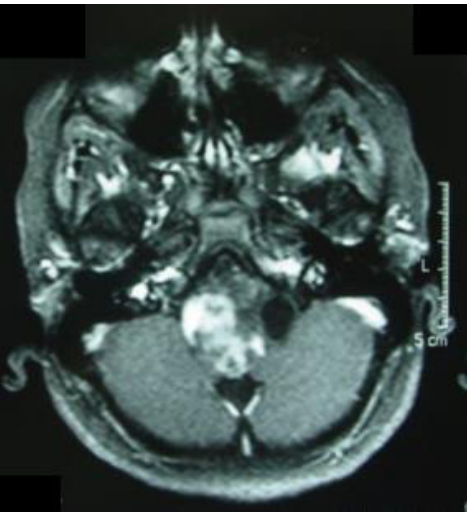
Figure 6– Pilocytic astrocytoma in the cervicomedullary transition (type IV) in a patient with type 1 neurofibromatosis.